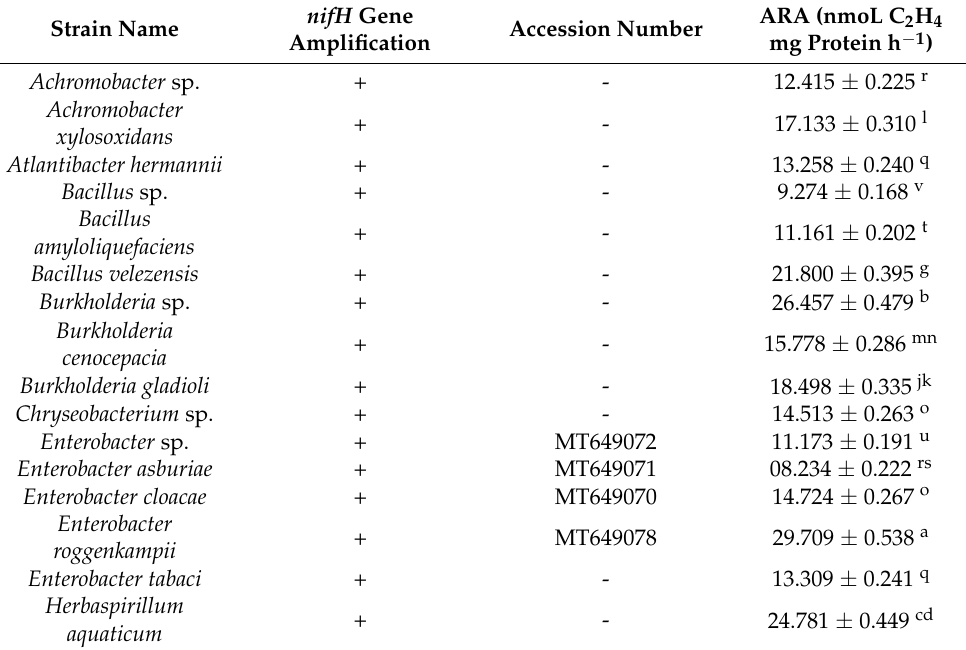
Table 1. PCR amplification of the nifH gene and nitrogenase activity of selected isolates through acetylene reduction